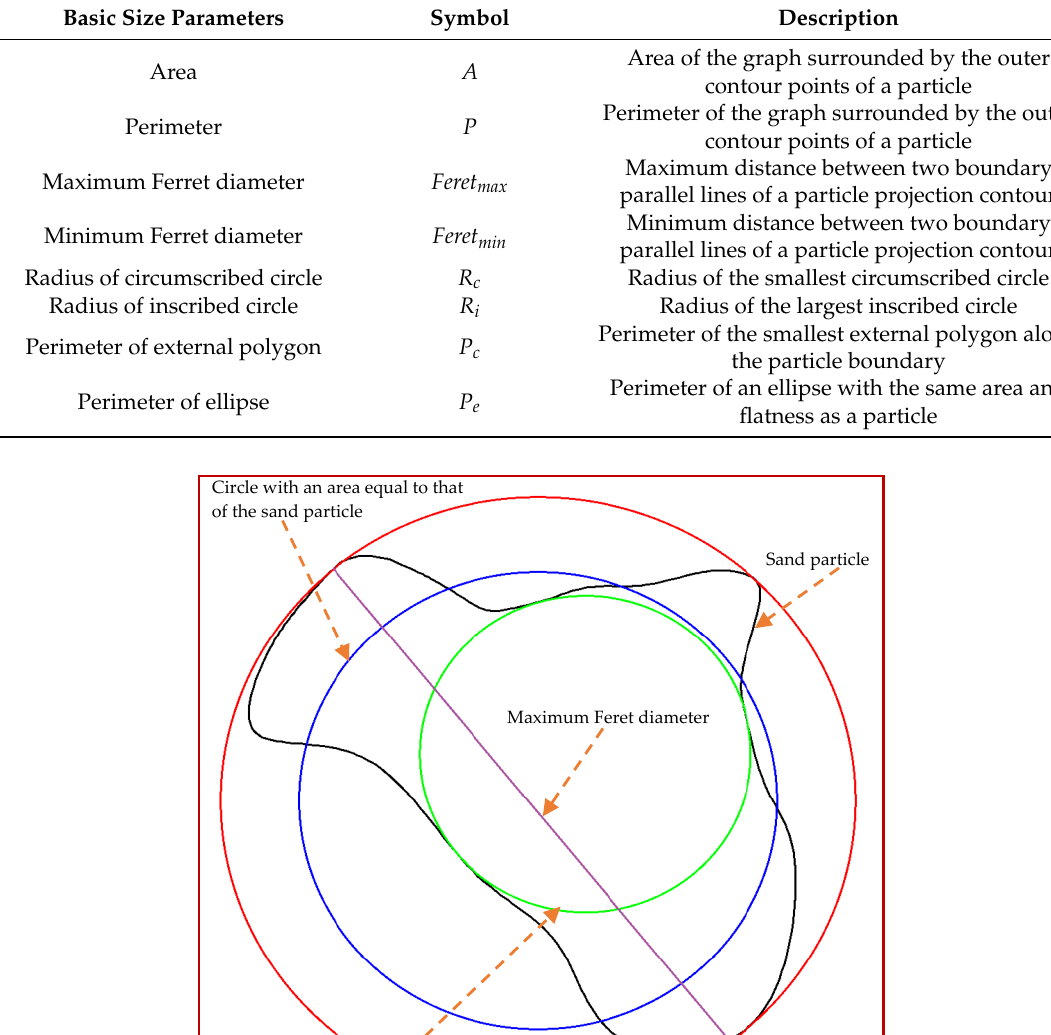
Edges and corners at the microscopic level